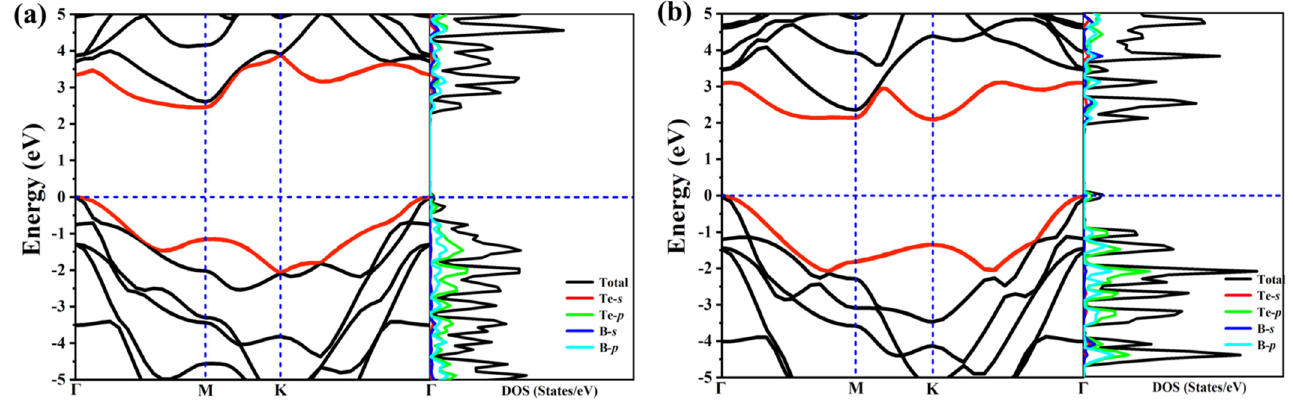
Figure 3. The calculated electronic band structure and PDOS of the α -TeB ( a ) and β -TeB ( b ) monolayers at the HSE06 level.